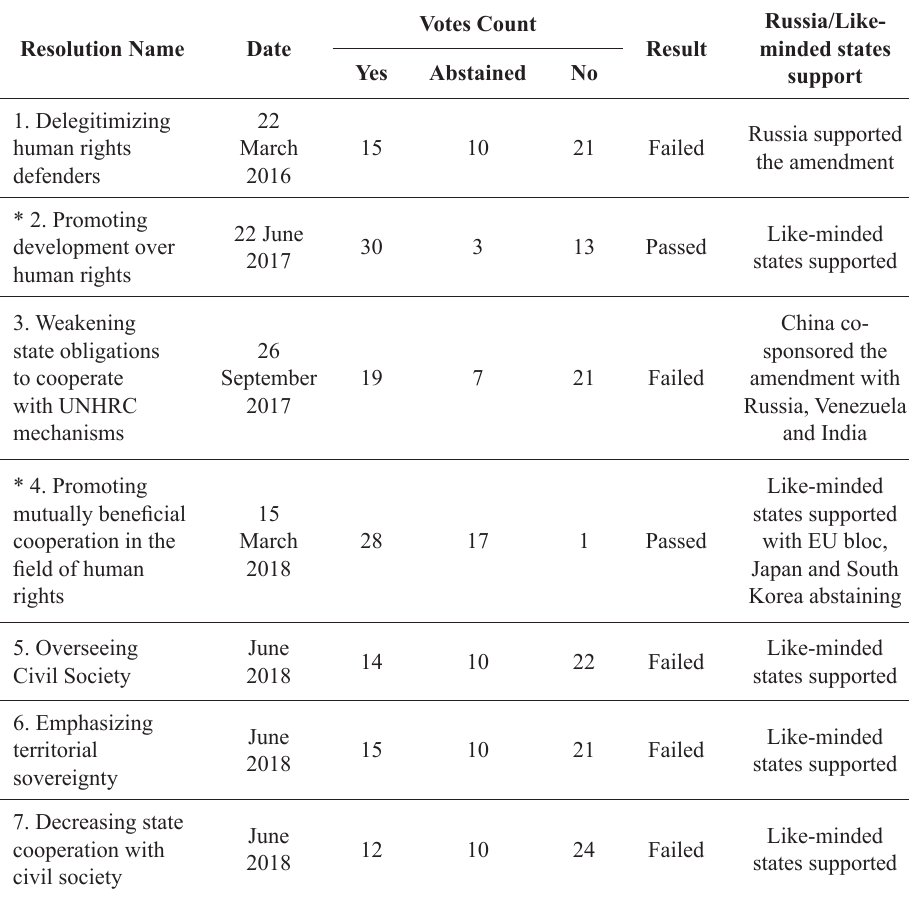
Table 2. Major Human Rights Council votes